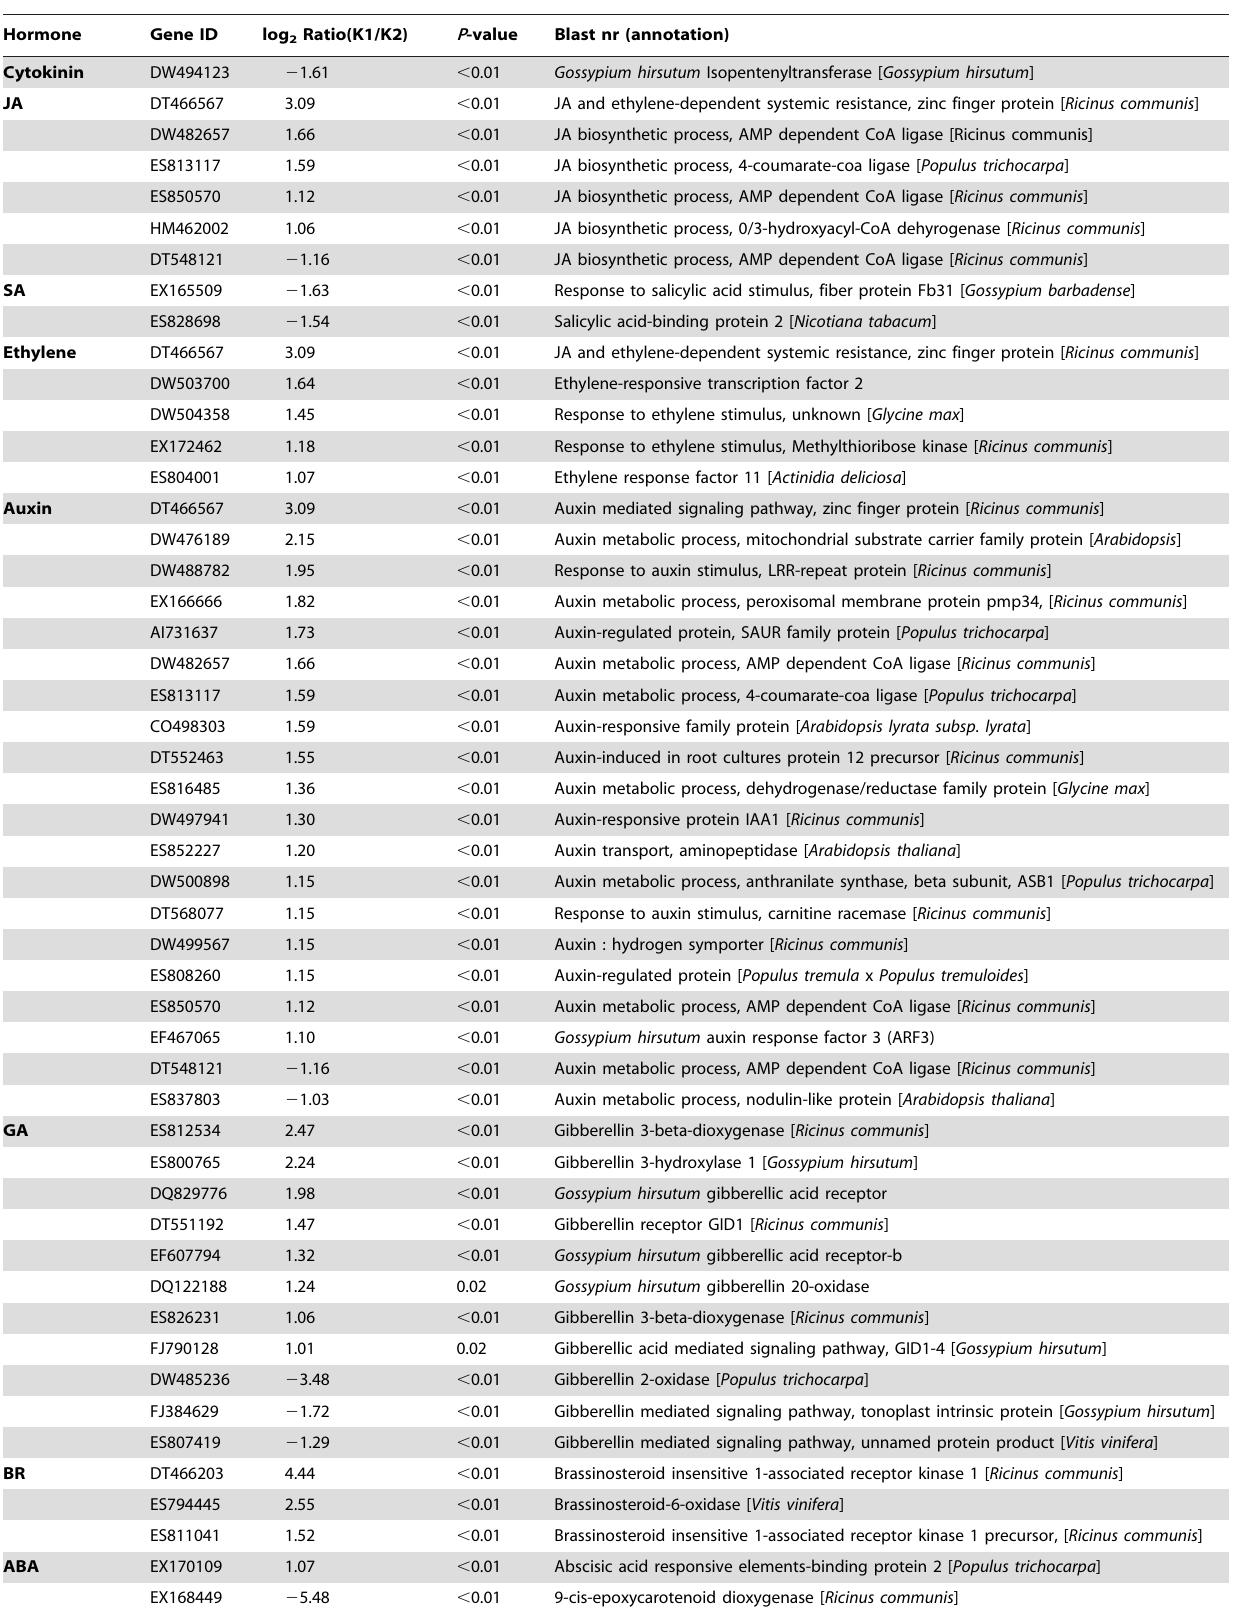
Table 3. Differently expressed hormone related genes identified using Solexa sequencing in cotton.